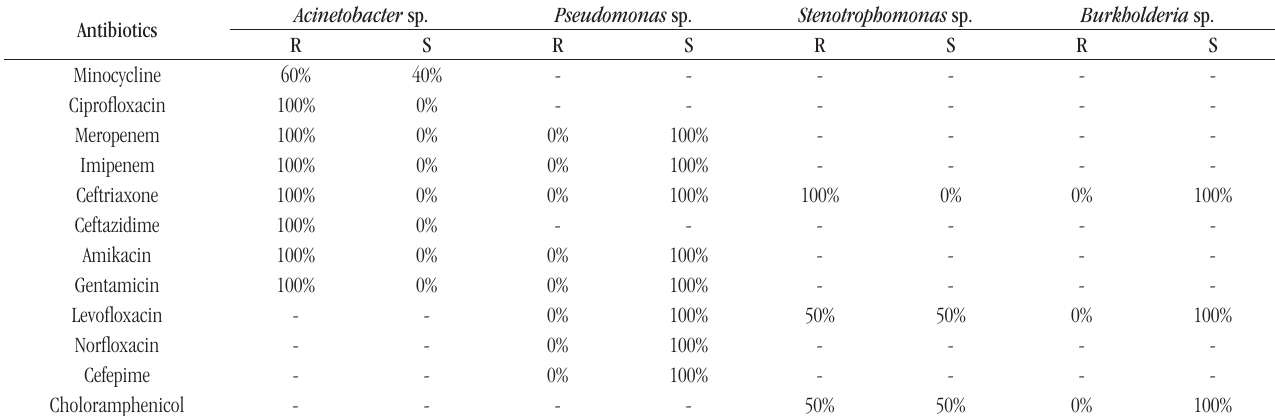
taBLE − Sensitivity and resistance profile of NFGNB isolated from blood cultures Acinetobacter sp. Pseudomonas Antibiotics